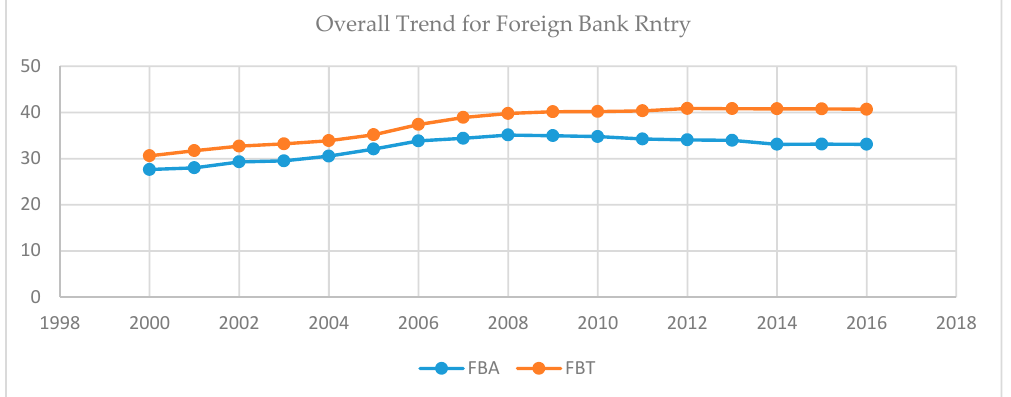
Figure 1. Overall trend of foreign bank entry across the globe. From 2000 to 2016, the banking system in different countries experienced essential transformations. The number of foreign banks and their assets has increased with time, which is also shown in Figures 1 and 2. All of these different trends mean that the relative importance of the foreign banks increased extensively, from some foreign banks of an average of 30.62% in 2000 to 40.69% in 2016 (Figure 2): Source: Author’s calculation, World Bank Global Financial development database.